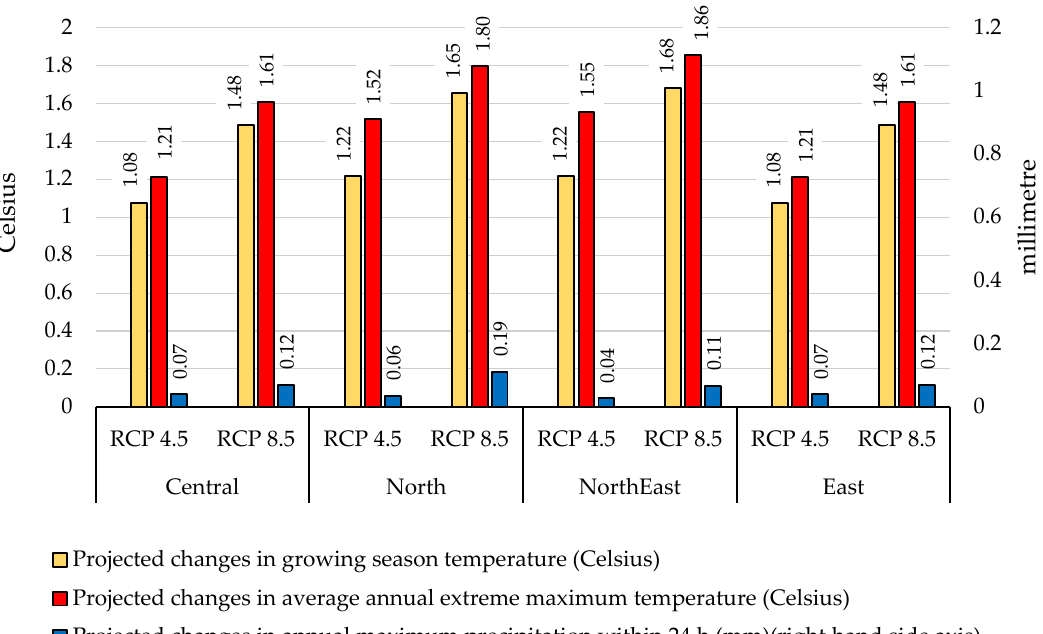
Figure 1. Projected changes in temperature (Celsius) during 2046–2055 under Representative Concentration Pathway (RCP)4.5 and RCP8.5 from the baseline during 1992–2016.